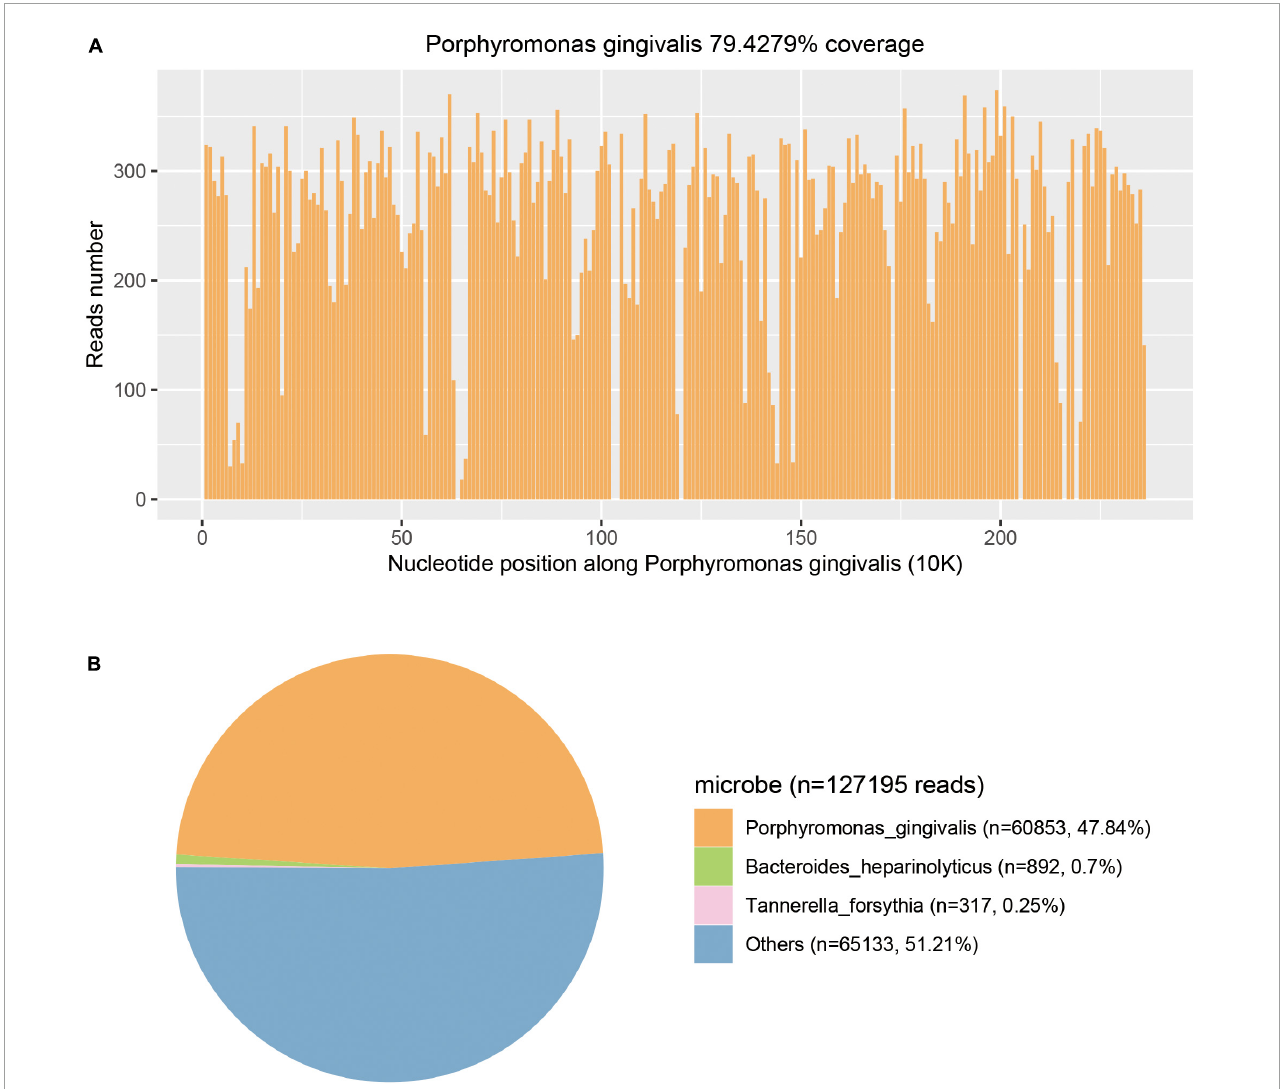
FIGURE4 Metagenomic next-generation sequencing (mNGS) results of this case. (A) Courage of Porphyromonas gingivalis detected by mNGS was 79.4279%. (B) A total of 60853 specific reads of P. gingivalis were detected by mNGS in this